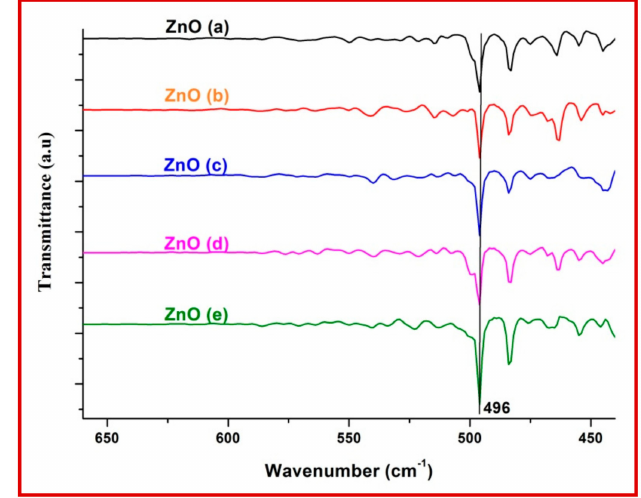
Figure 6. FT-IR Spectra of ZnO-NPs prepared using di ff erent concentrations of C. verum